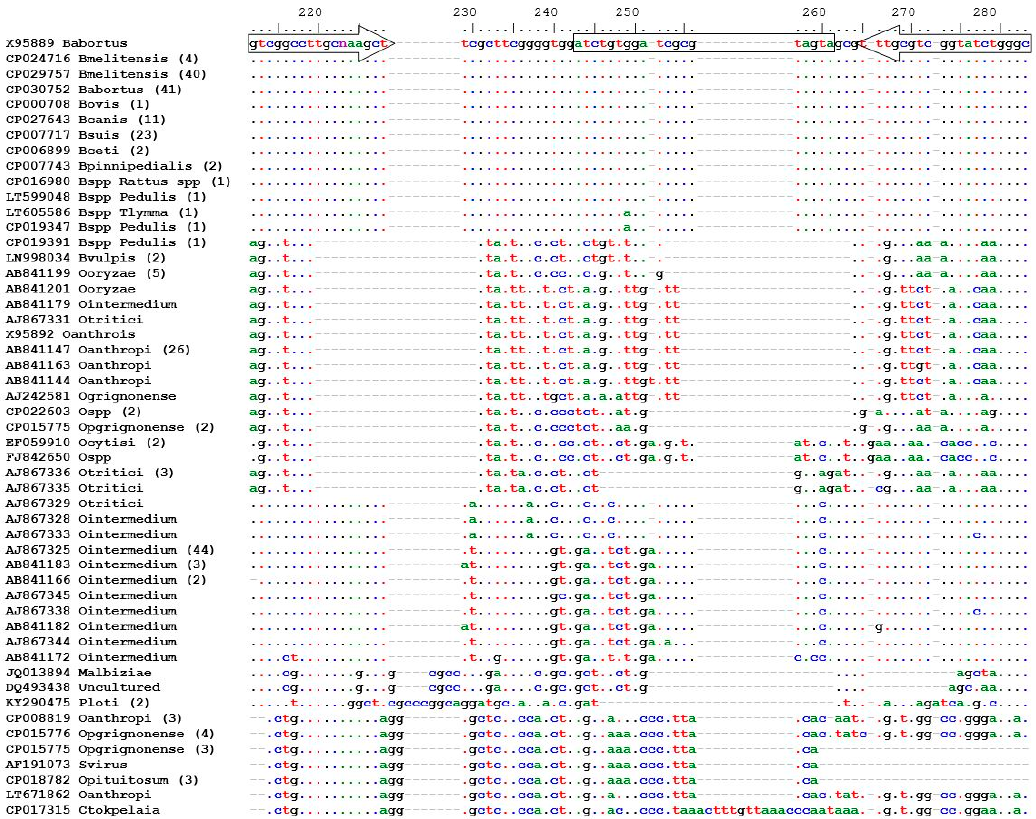
Figure 1. Multiple sequence alignment of the 16S ‐ 23S rDNA internal transcribed spacer (ITS) region of Brucella spp. and closely related Ochrobactrum spp. available on GenBank ® . Primers and probe have been indicated by arrows and a rectangle respectively. X95889 was used for the nucleotide position numbering. Identical sequences have been grouped and labelled with a randomly selected sequence in the group. The number of identical sequences in a group is indicated in brackets after the name of the group. Table 3. Primers and TaqMan ® minor groove binder (MGB) probe targeting the 16S-23S internal transcribed spacer (ITS) region of Brucella spp. and labelled with 6-caboxyfluorescein (6-FAM)